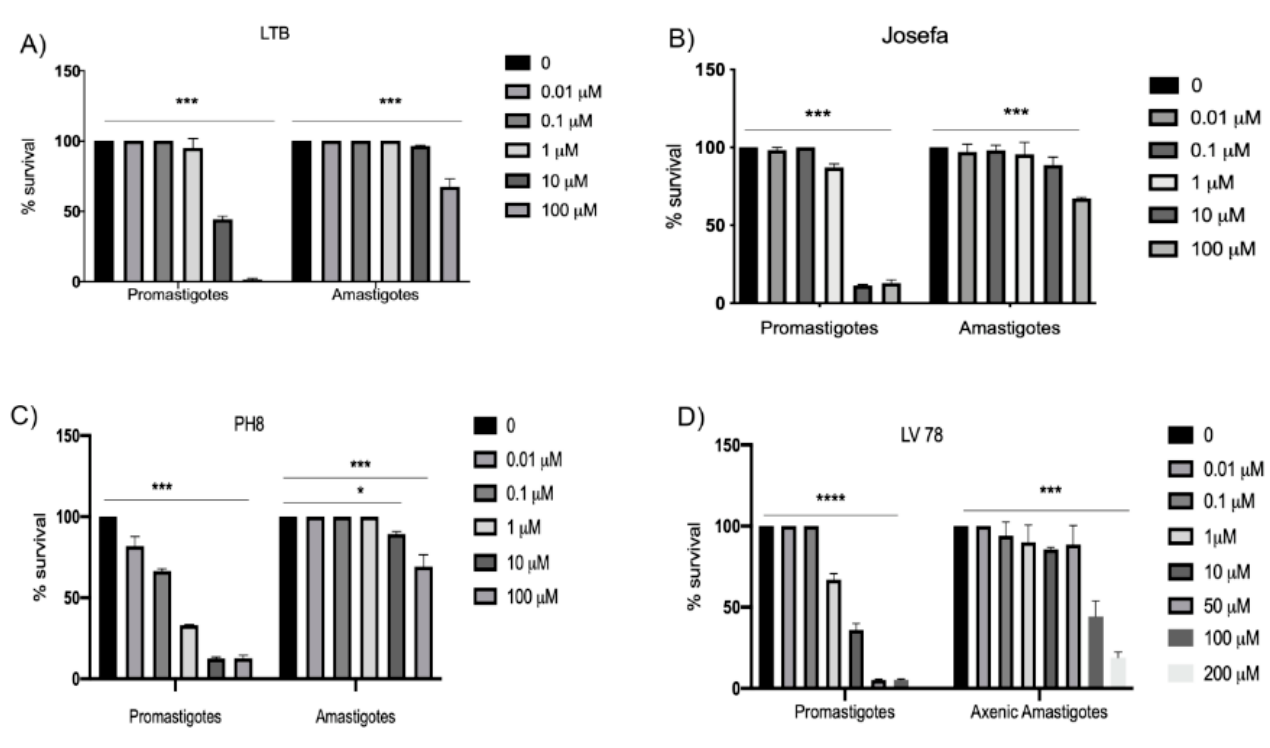
Figure 5. Survival percentage of promastigotes and intracellular amastigotes treated with PF-429242. L. amazonensis promastigotes, and intracellular or axenic amastigotes were treated with different concentrations of PF-429242 for 72 h. ( A ) LTB, ( B ) Josefa, ( C ) PH8, and ( D ) LV78. Promastigotes measured by resazurin or MTT. Infected macrophages were fixed, stained with Panotico and counted on a microscope. The total number of amastigotes within 100 macrophages were assessed. Graphs show the average from three independent experiments. Statistical analysis by one-way ANOVA followed by Tukey’s post-test was performed to compare results with the untreated control. **** p < 0.0001, *** p < 0.001, * p < 0.05.